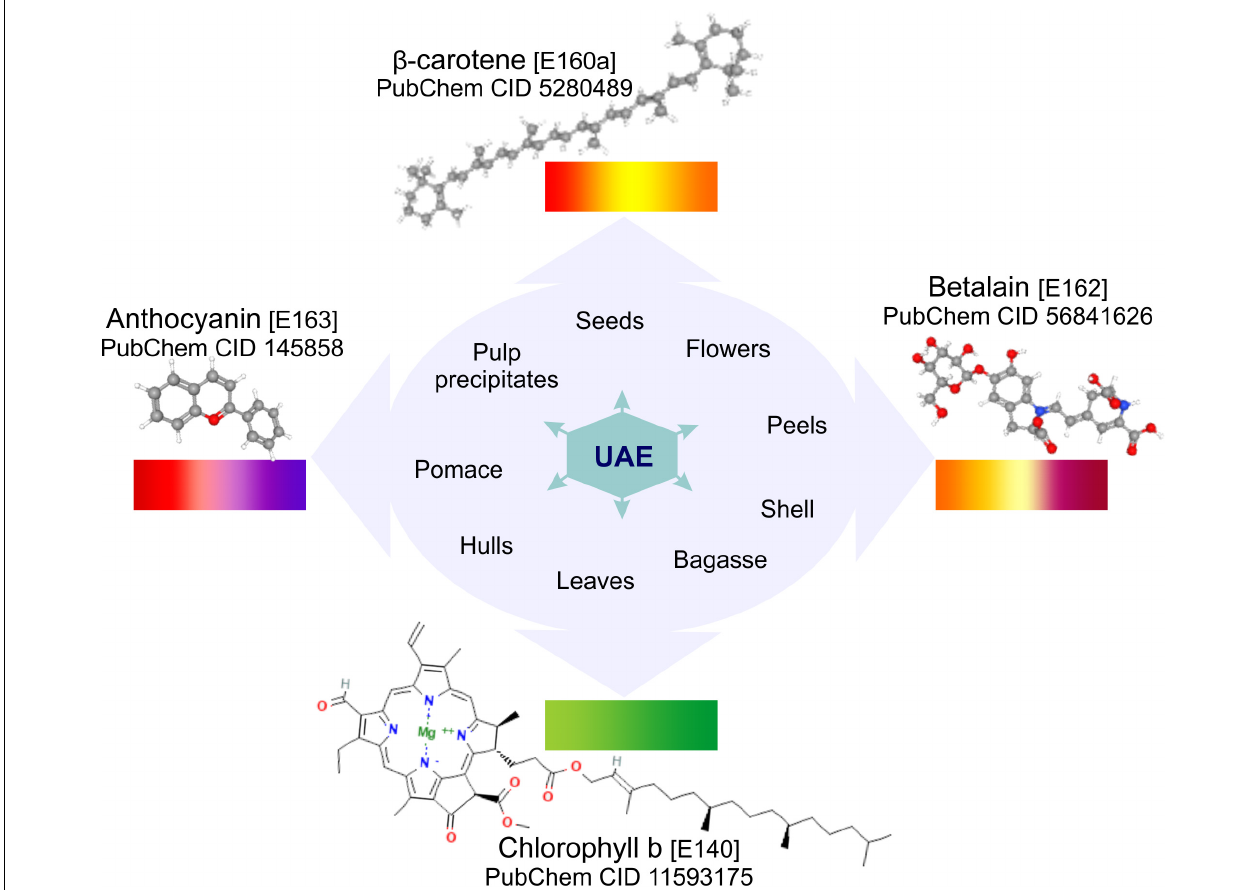
FIGURE 1 | Basic molecular structure of carotenoids, anthocyanins, betalains and chlorophyll obtained from PubChem (123), the natural pigments which can be recovered by UAE from different food